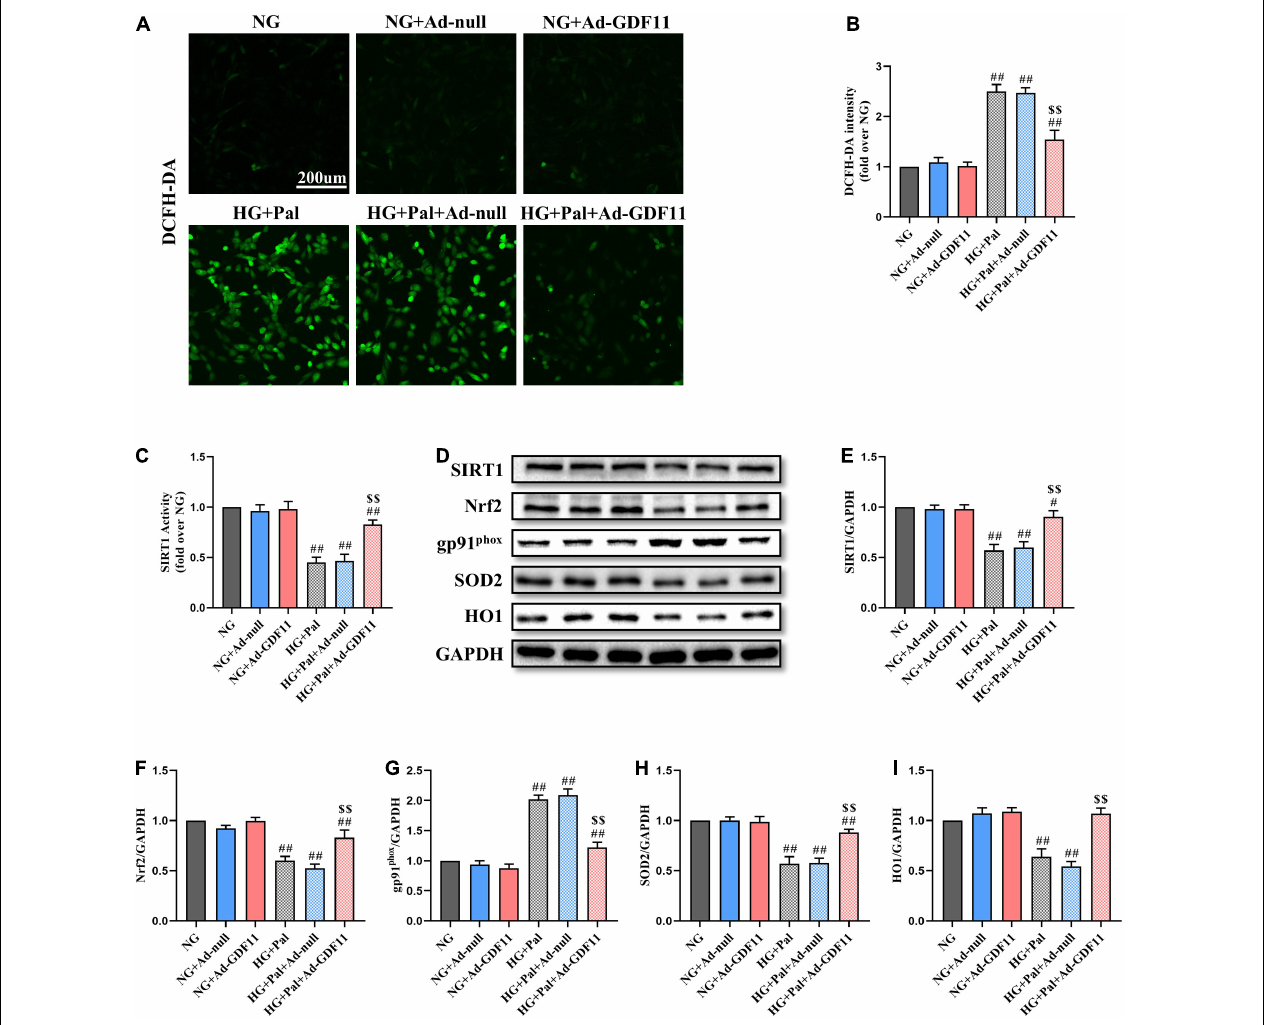
FIGURE 6 | GDF11 overexpression attenuated high glucose (HG) and palmitate (Pal) induced reactive oxygen species (ROS) overproduction in H9c2 cells. (A) Representative images of 2’,7’-dichlorofluorescein diacetate (DCFH-DA) staining (scale bar = 200 µ m). (B) DCFH-DA fluorescence intensities. (C) The deacetylase activity of SIRT1. (D) Representative blots of SIRT1, Nrf2, gp91 phox , SOD2, and HO1. (E) Quantitative expression of SIRT1. (F) Quantitative expression of Nrf2. (G) Quantitative expression of gp91 phox . (H) Quantitative expression of SOD2. (I) Quantitative expression of HO1. Data are presented as the mean ± SEM, n = 5 or 6 per group. # / ## P < 0.05/0.01 versus the NG group, $$ P < 0.01 versus the HG + Pal